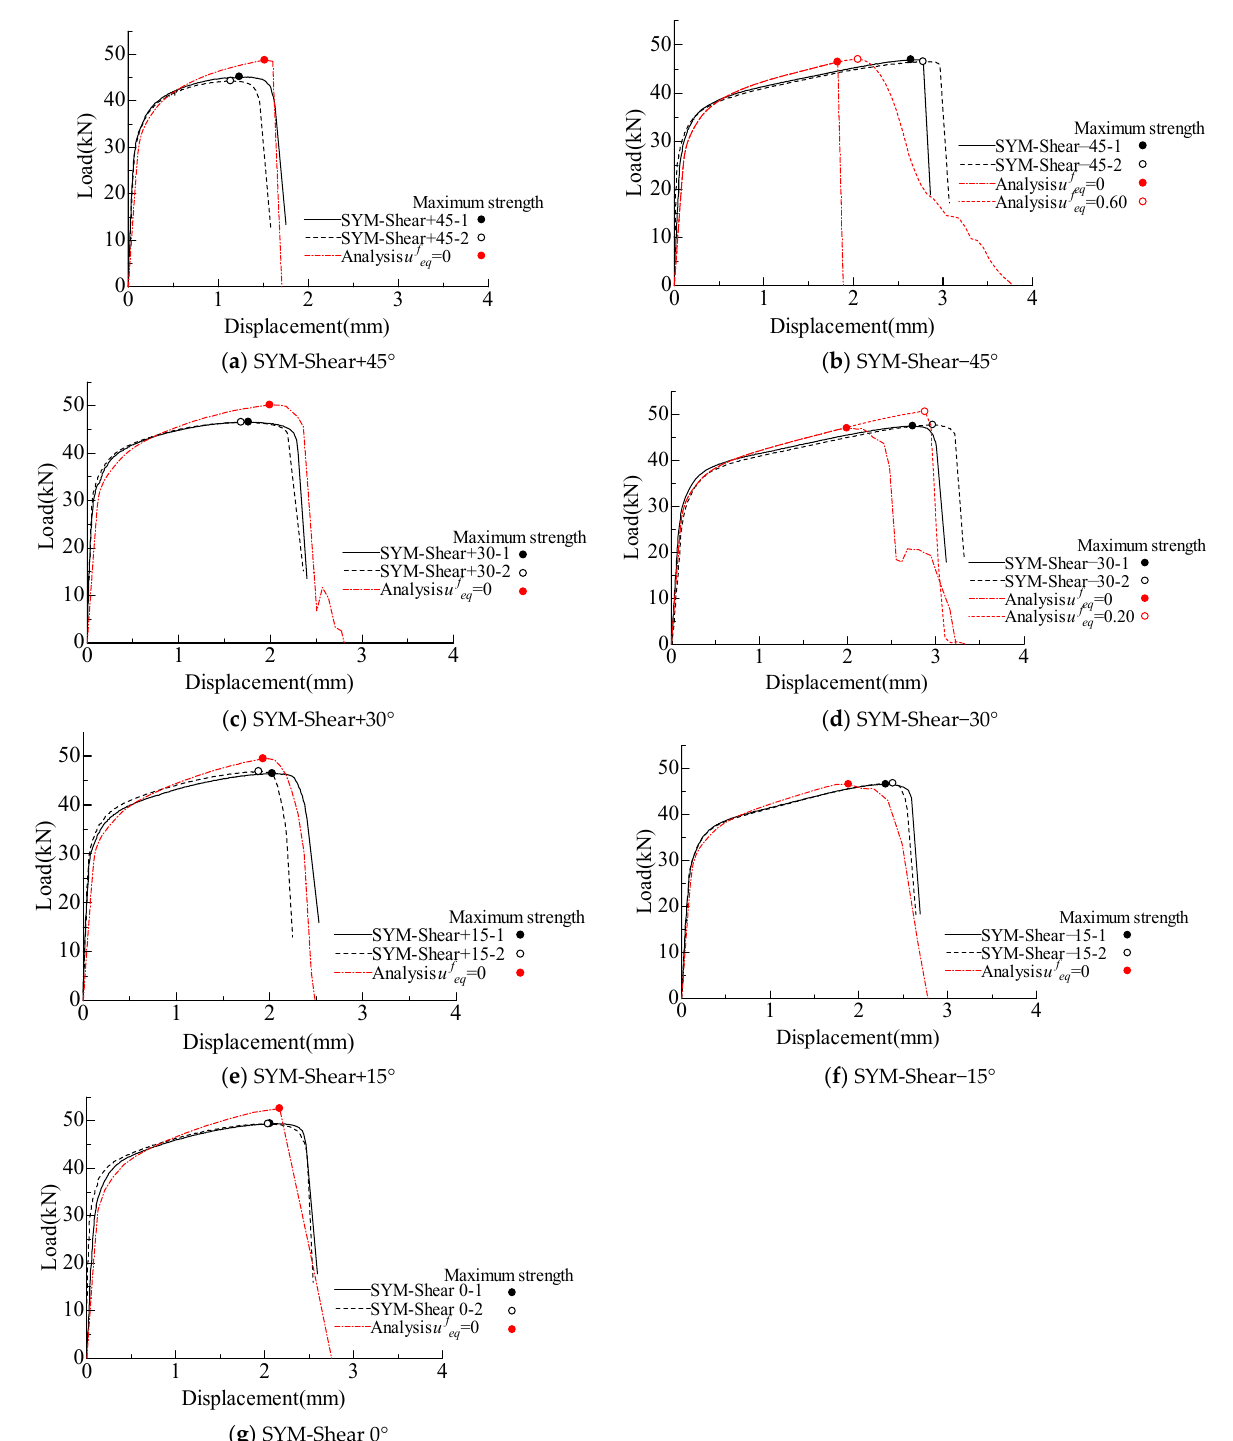
Figure 16. Comparison of experimental results and analysis results using the modified N-VG model (SYM-Shear specimens).